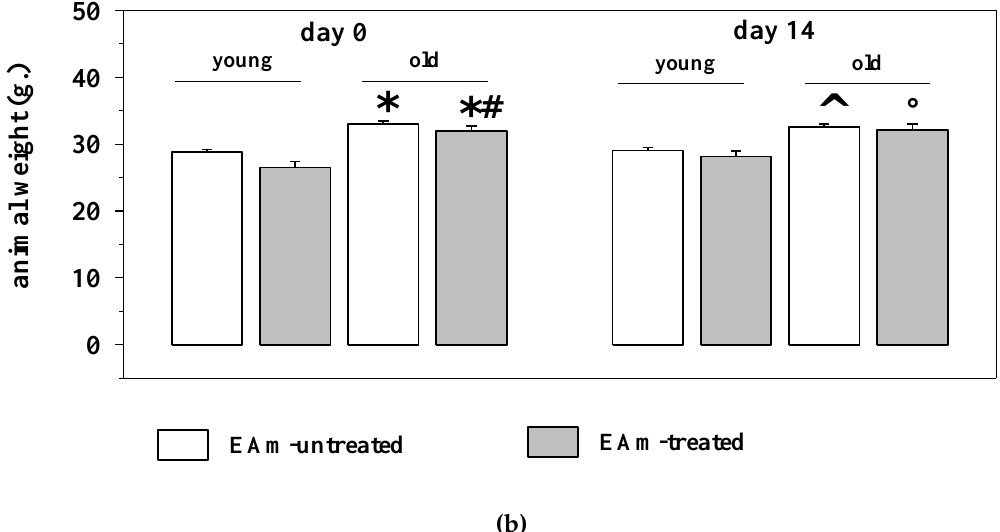
Figure 1. Daily intake and animal weight changes during the ellagic acid micro-dispersion (EAm) treatment. ( a ) daily EAm intake (mL) in young (empty bar) and old (black bar) mice during the 14 days EAm treatment. The daily intake is expressed as mean ± SEM of the amount of EAm taken up by 8 animals for each group. ( b ) Animal weight (g.) in EAm-untreated (empty bar) or EAm-treated (gray bar) young and old mice before (day 0) and at the end (day14) of the EAm treatment. The weight is expressed as mean ± SEM of the amount of EAm taken up by n = 8 animals for each group. Statistical analysis was performed by applying ANOVA followed by Tukey’s Multiple Comparison test. * p < 0.05 vs. young mice at day 0 of EAm-treatment; # p < 0.05 vs. old mice at day 0 of EAm-treatment; ˆ p < 0.05 vs. young mice at day 14 of EAm-treatment; ◦ p < 0.05 vs. old mice at day 14 of EAm-treatment.